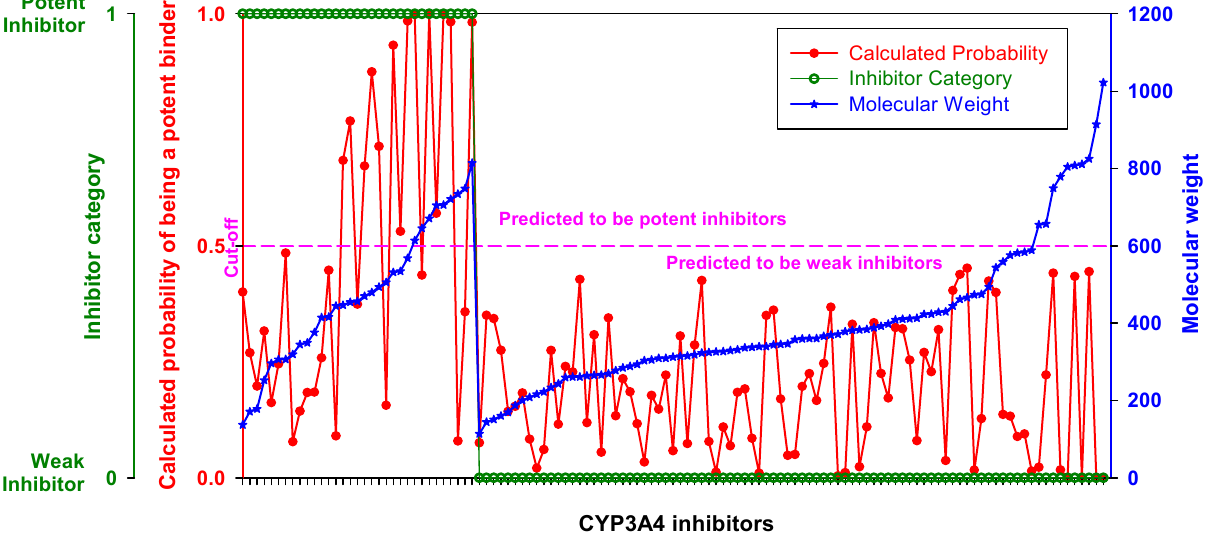
Figure 3. Performance of the DLR model. Potent and weak CYP3A4 inhibitors were sorted by molecular weight, which is shown in blue; their clinical categorization is shown in green; calculated probability scores are depicted in red. The dashed line denotes a chosen probability cut-off for the LR